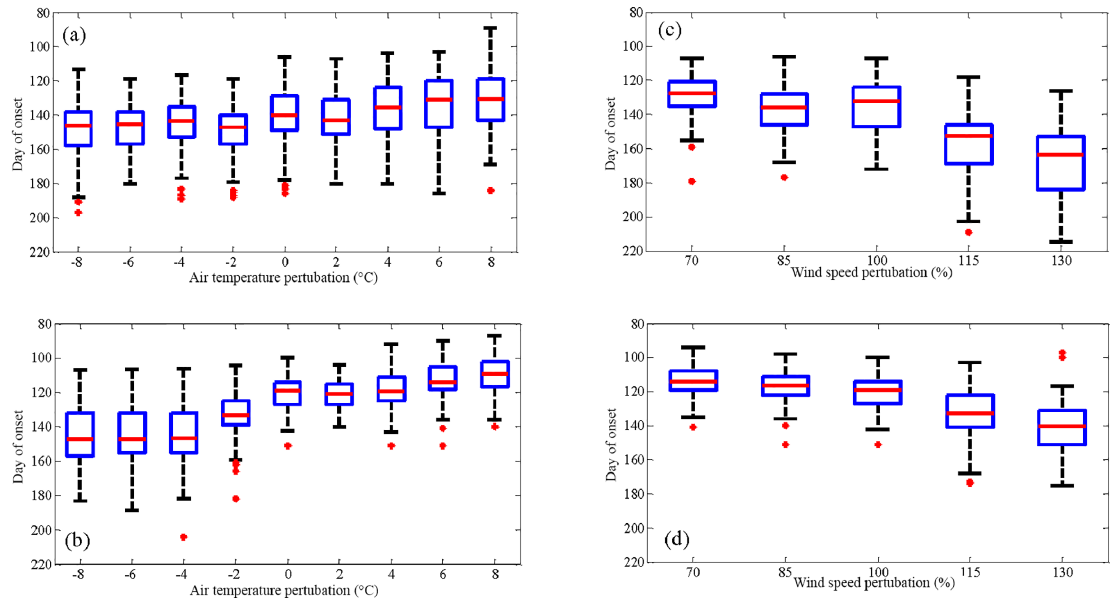
Figure 9. Day of stratification onset under select air temperature perturbation scenarios for (a) Lake Mendota and (b) Fish Lake and day of stratification onset under select wind speed perturbation scenarios for (c) Lake Mendota and (d) Fish Lake. The box represents the 25th and 75th quartiles and the central line is the median value. The whiskers extend to the minimum and maximum data points in the cases where there are no outliers, which are plotted individually.